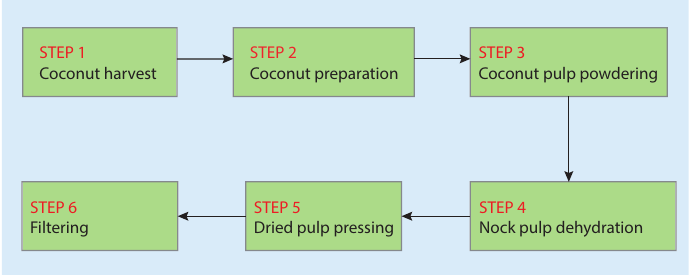
Figure 6. Standard coconut oil extraction